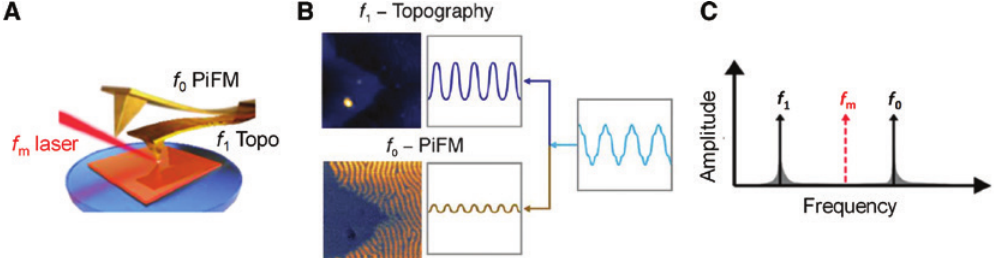
Figure 4: Enhancement of signal by using multiple mechanical resonances of the cantilever [26, 47]. (A) Schematic diagram of sideband driven enhancement for photo-induced force microscopy (PiFM). (B) Cantilever’s position decomposed into eigenmodes with the frequency of f (up) and f (down), which provides the information of topography and photo-induced force 1 0 respectively. (C) Photo-induced force (right peak) and its sideband (left peak) modulated by the cantilever’s oscillation (dashed arrow in red) in frequency domain (Figures adapted from Refs. [26, 47]).